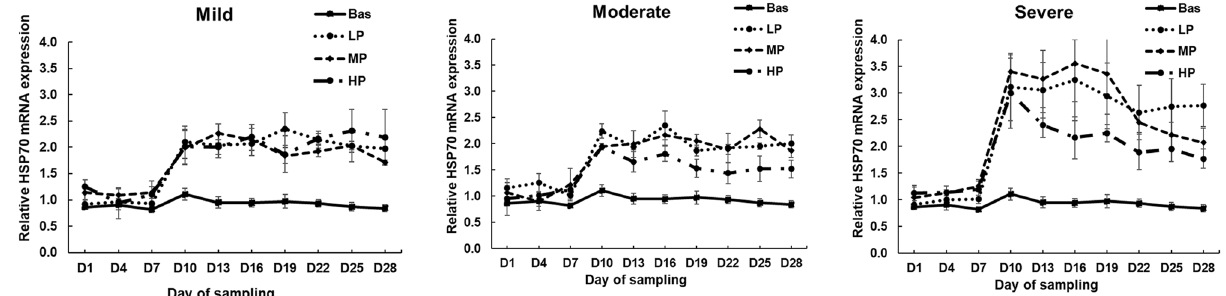
Figure 3. Effects of dietary protein levels on the mRNA expression of HSP70 in the PBMCs of calves during the climate chamber experiment. The data are presented as the means ± standards error (n = 4/group) (protein: P = 0.08, HS: P < 0.01, day: P < 0.01). Threshold = THI 70 to 73, Mild = THI 74 to 76, Moderate = THI 81 to 83, Severe = THI 89 to 91. LP = Low protein (12.5%), MP = Medium protein (15%), HP = High protein (17.5%).